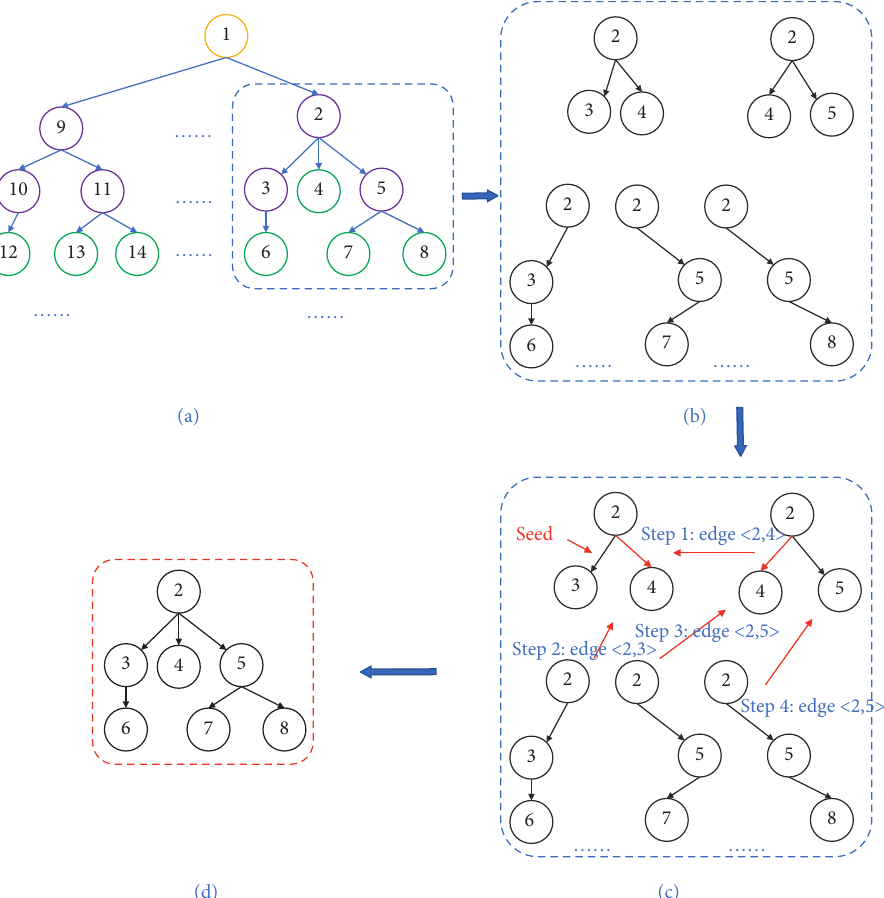
Figure 2: Community detection procedure in an information propagation tree with the triad percolation. (a) An example IPT; (b) open triads extracted from the IPT; (c) the procedure: first, an open triad is selected randomly as the initial seed for community C . Then, an open triad ot is selected and merged into C if ot and C have the same edge, and a new community C ′ comes into being. Finally, C � C ′ . The above process is repeated until the community meets the evaluation criteria detailed in [11], or there are no more open triads need to be merged; (d) the final community